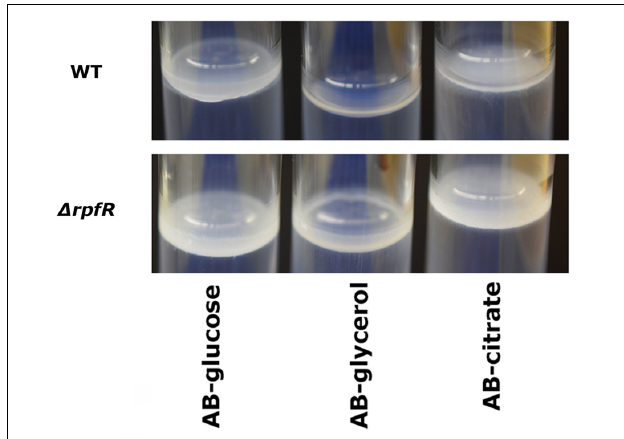
FIGURE 3 | Pellicle formation of B. cenocepacia H111 and the rpfR mutant in static batch cultures. Wild type and mutants were grown at 30 ◦ C in ABnoNaCl supplemented with 10 mM glucose, 10 mM glycerol or 10 mM citrate, respectively, in glass tubes and sealed with parafilm to diminish evaporation but allow air exchange. Pictures of pellicles were captured after 72 h.